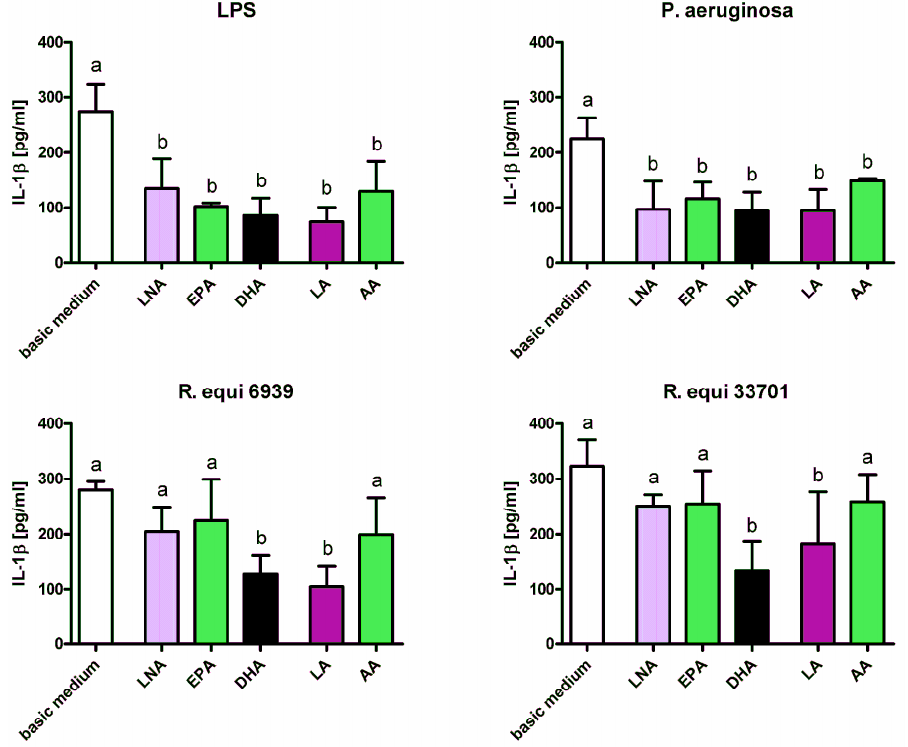
Figure 2. Concentration of IL-1 β in supernatants of RAW264.7 macrophages cultured in basic medium as well as in medium supplemented with 15 µmol/L alpha-linolenic acid (LNA), eicosapentaenoic acid (EPA), docosahexaenoic acid (DHA), linoleic acid (LA) or arachidonic acid (AA) after 24 h of stimulation with LPS, P. aeruginosa ATCC 10145, R. equi ATCC 6939 and R. equi ATCC 33701 respectively. Data are mean ± SD ( n = 6). Bars denoted by different letters are significantly different.